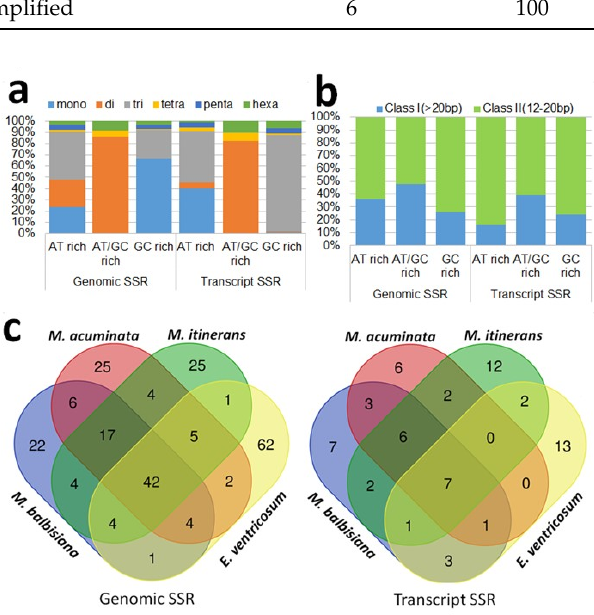
Figure 2. ( a , b ) frequency distribution of SSR motif; ( c ) transferability of genomic and transcript SSR markers in four relatives of B. rotunda . The annotation of the predicted protein-coding genes was a combination of homol- ogy-based and de novo prediction in addition to comparison with the B. rotunda transcrip- tome data (Table S4). After consolidation, 73,102 protein-coding genes were predicted in the B. rotunda genome with an average transcript length of 4312 bp (excluding UTR), CDS length of 1360 bp, average exon and intron lengths of 303 bp and 812 bp, respectively, and 4.49 exons per gene (Table S4). For the homology-based protein-coding gene predictions, the protein sequences from four species ( M. acuminata , Phoenix dactylifera , Oryza sativa and Arabidopsis thaliana ) were mapped onto the B. rotunda genome. From these alignments, B. rotunda had the highest number of matches with P. dactylifera followed by O. sativa , A. thaliana and M. acuminata (Figure S8). Functional annotation of the 73,102 predicted pro- teins from B. rotunda against seven databases enabled functional predictions for 97.8% of the predicted genes (Table 6). Non-coding RNA analysis of the assembly identified 213 microRNA (miRNA), 2727 transfer RNA (tRNA), 486 ribosomal RNA (rRNA), and 2136 small nuclear RNA (snRNA) genes (Table 7). Table 6. Statistics of function annotation. Database